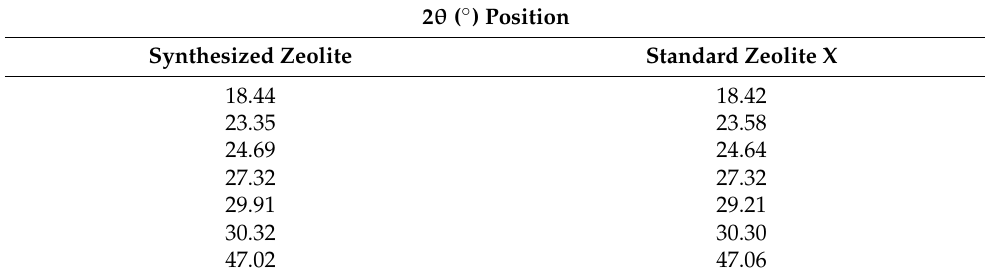
Table 2. Data on the peak positions on the diffractogram of synthesized zeolite and standard zeolite X. 2 θ ( ◦ ) Position